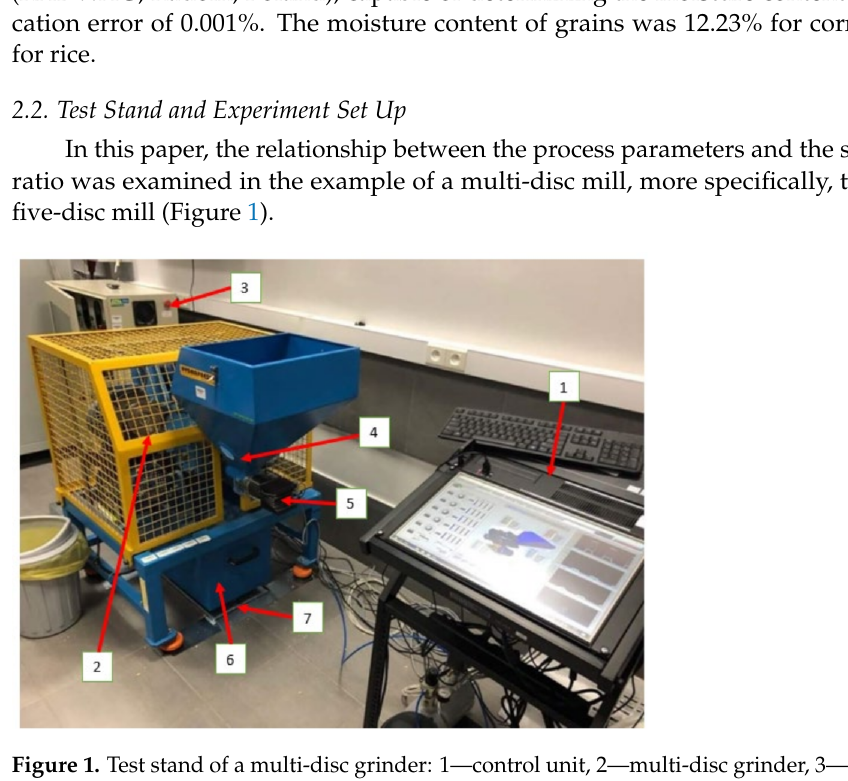
Figure 1. Test stand of a multi-disc grinder: 1—control unit, 2—multi-disc grinder, 3—control cabinet, 4—screw feeder, 5—step motor, 6—receiving basket, 7—scale